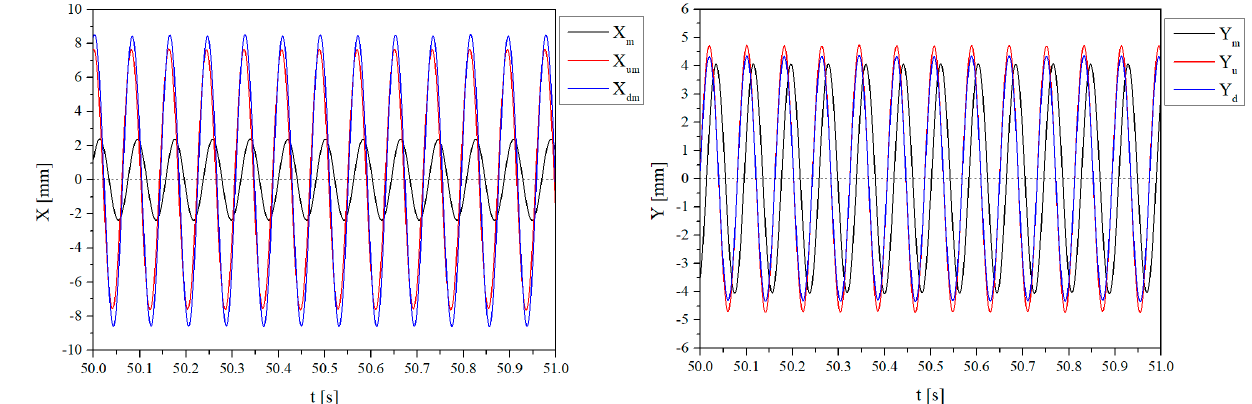
Figure 6. Time − domain amplitude curves: (a) x direction, (b) y direction. Figure 6. Time domain − amplitude curves: ( a ) x direction and ( b ) y direction.